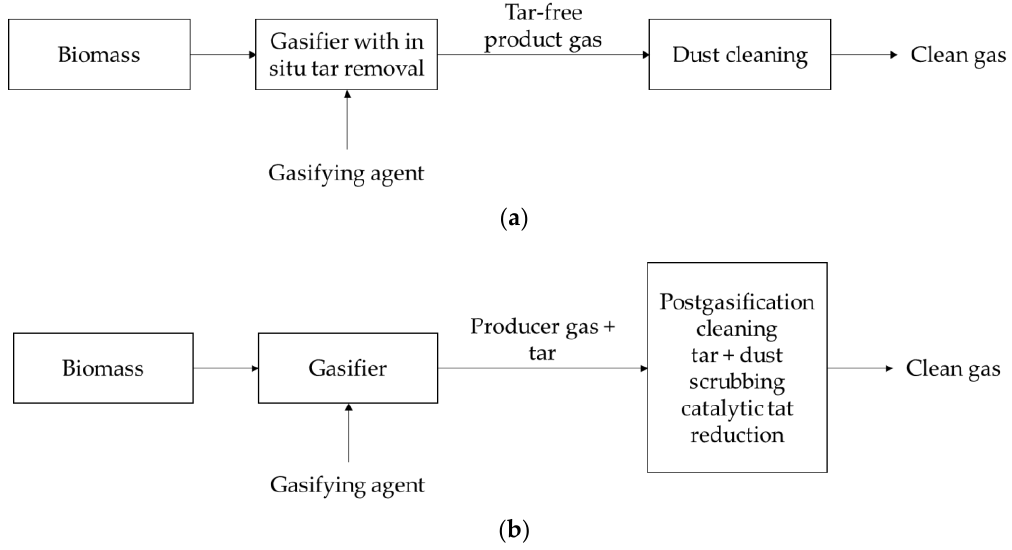
Figure 1. The two major tar-reduction methods. ( a ) In situ tar reduction (primary reduction); ( b ) Post- gasification tar reduction (secondary reduction). ( b ) Post-gasification tar reduction (secondary